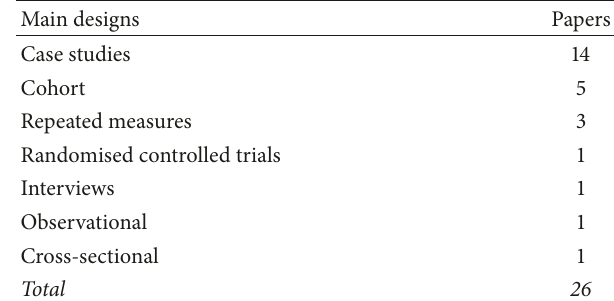
Table 1: Papers grouped by clinical purpose of use.